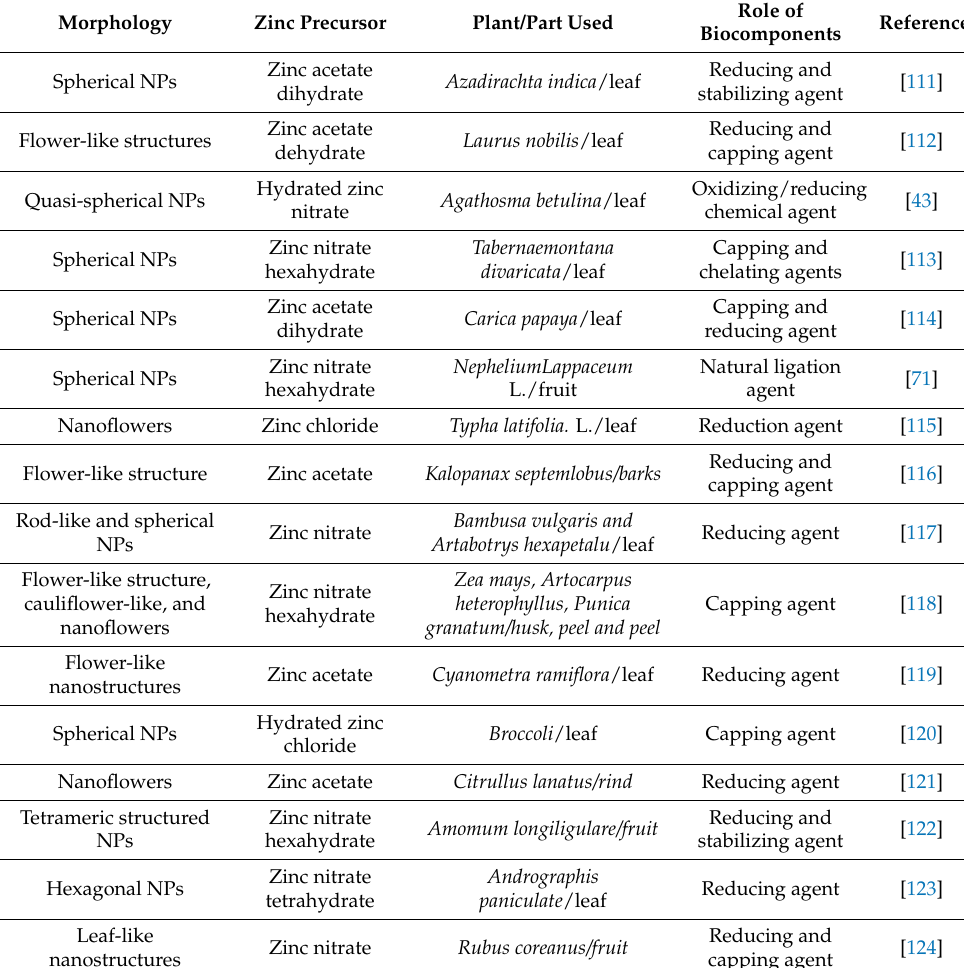
Table 4. Green co-precipitation syntheses of ZnO nanostructures mediated by plant extract.